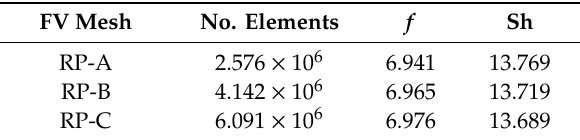
Table 4. Grid dependence results in CFD ( P / H = 10, Re τ = 5, and γ = 90 ◦ ). FV Mesh No. Elements